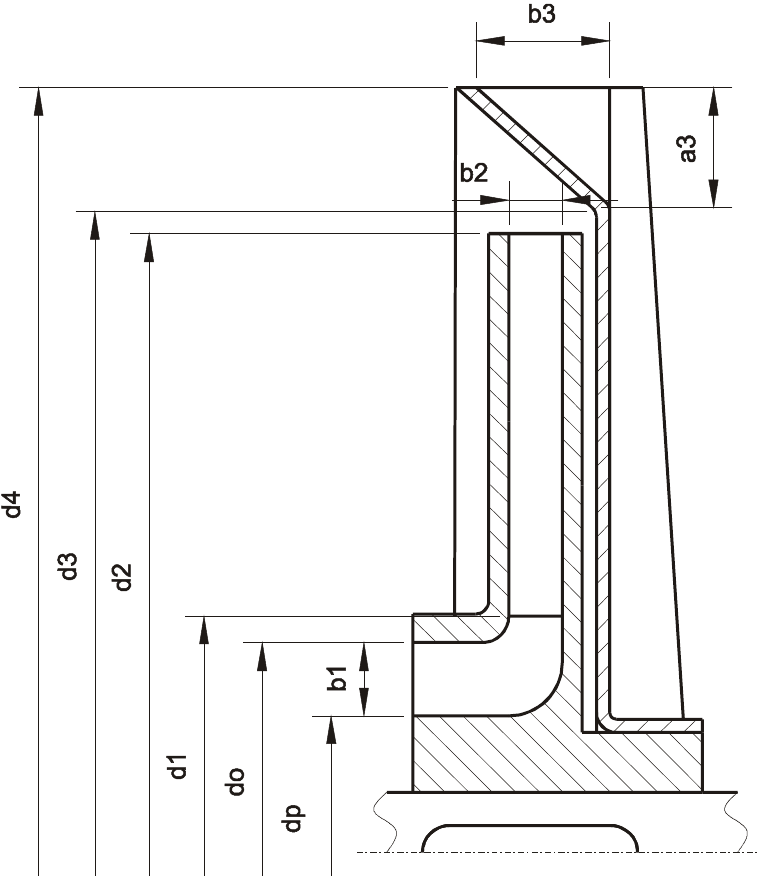
Figure 5. Characteristic dimensions of the pump stage.